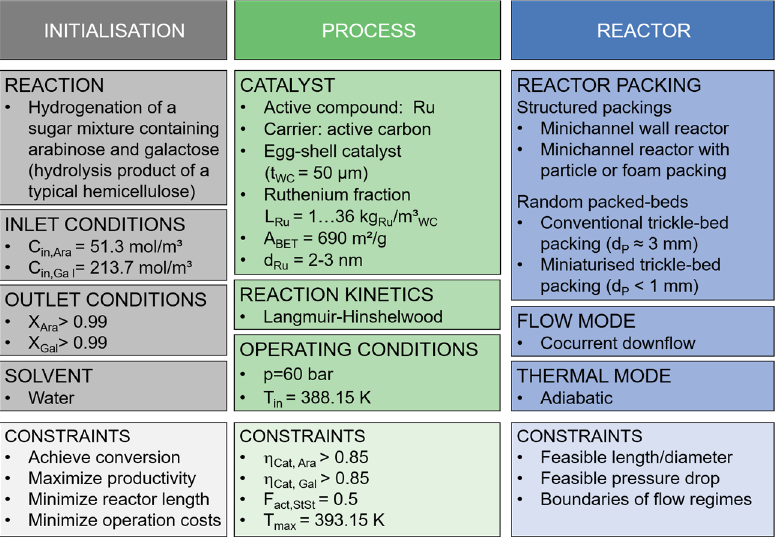
Figure 2. Overview of parameters and constraints in the case scenario.